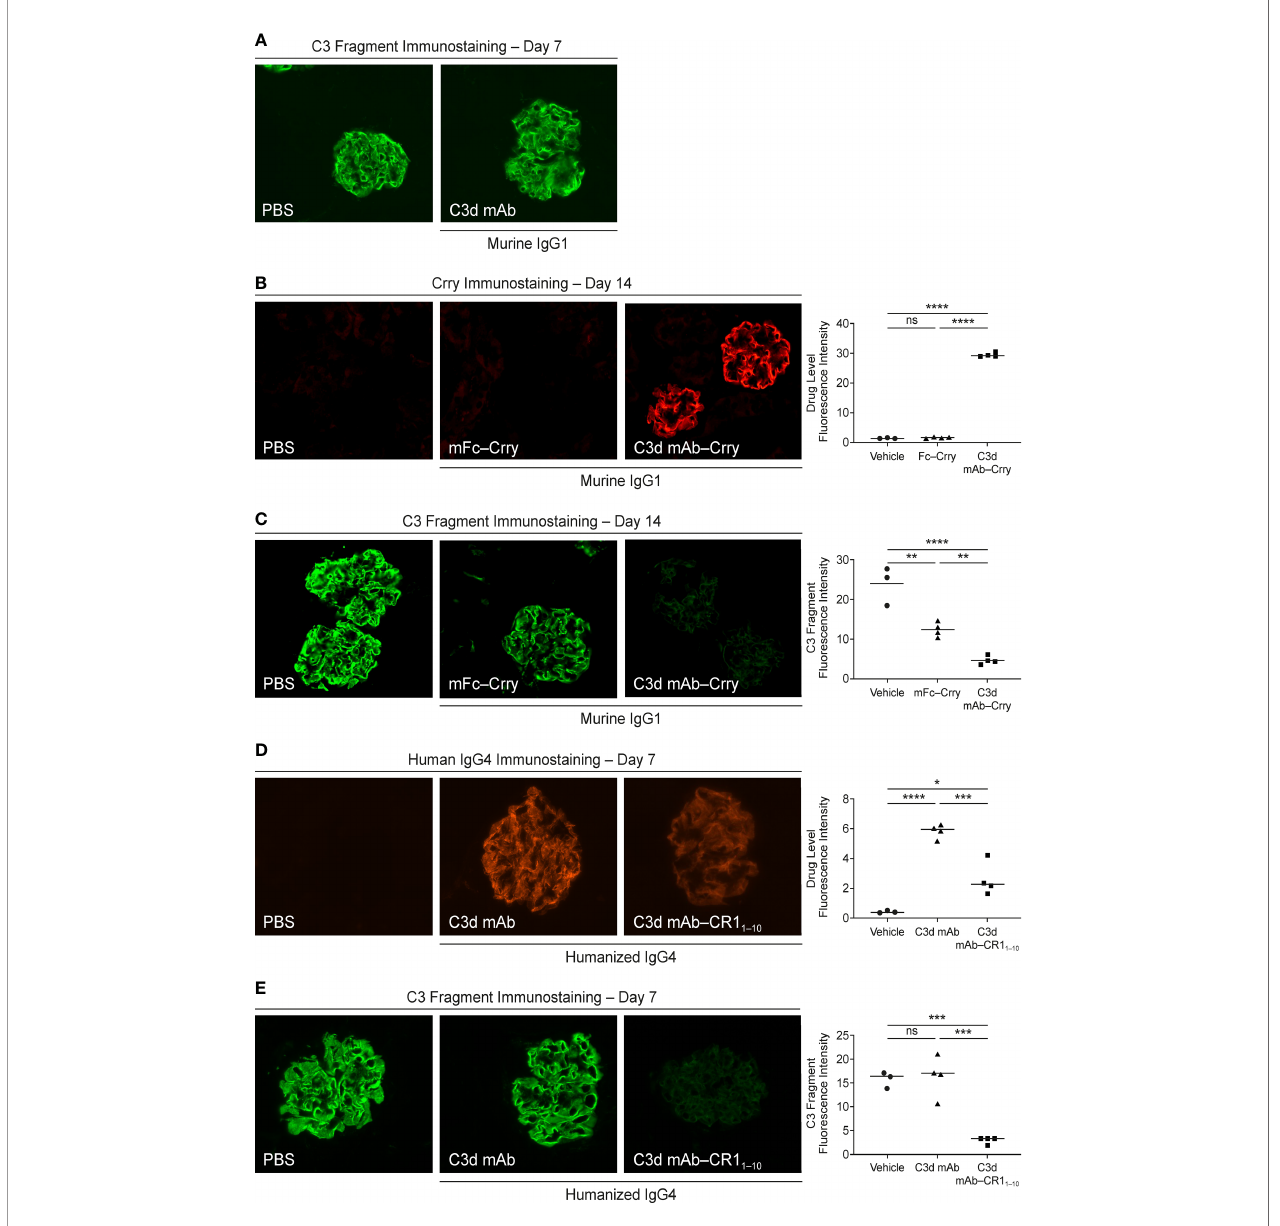
FIGURE 8 | Evaluation of CfH -/- mouse kidney tissue for fusion protein biodistribution/tissue PK (anti-Crry or anti-hIgG4 immunostaining) and tissue PD/ complement activity (anti-C3 fragment immunostaining). (A) C3 fragment immunostaining 7-days post-treatment with PBS and C3d mAb; (B, C) Crry and C3 fragment immunostaining 14-days post-treatment with PBS, C3d mAb – Crry or Fc − Crry; (D, E) human IgG4 and C3 fragment immunostaining 7-days post- treatment with PBS, humanized C3d mAb or humanized C3d mAb-CR1 1-10 . All images were acquired at 40x magni fi cation. Quantitation of drug level and C3 fragment staining intensity is expressed as an average of glomerular intensity from 6 or more glomeruli per sample (ImageJ analysis) using one-way ANOVA with Tukey ’ s post hoc test. ns, not signi fi cant; *P < 0.05; **P < 0.01; ***P < 0.001; ****P < 0.0001 vs vehicle or study